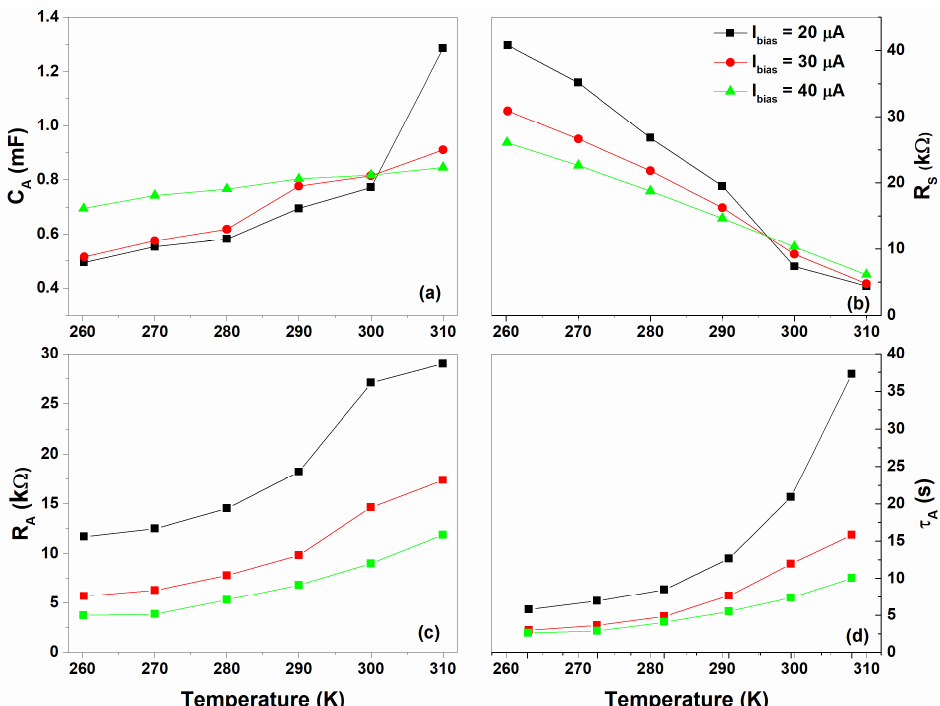
Figure 10. Temperature dependence of the ( a ) capacitance C A , ( b ) series resistance R S , ( c ) faradaic resistance R B and ( d ) time constant τ A computed from the fitting procedure at bias current range between 20 and 40 μ A, respectively.